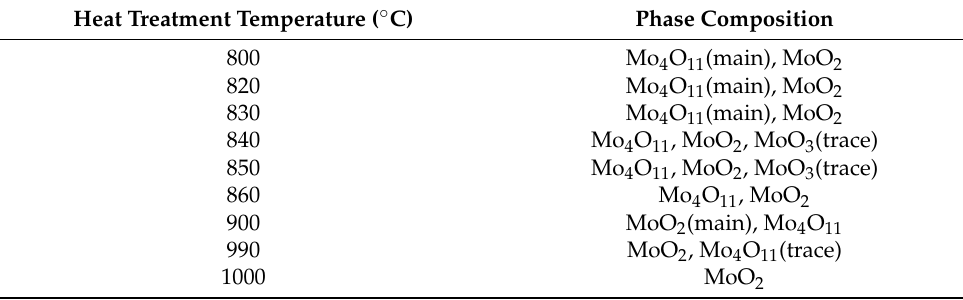
Table 2. Phase compositions of the Mo 4 O 11 powders after heat treatment. Heat Treatment Temperature ( ◦ C)